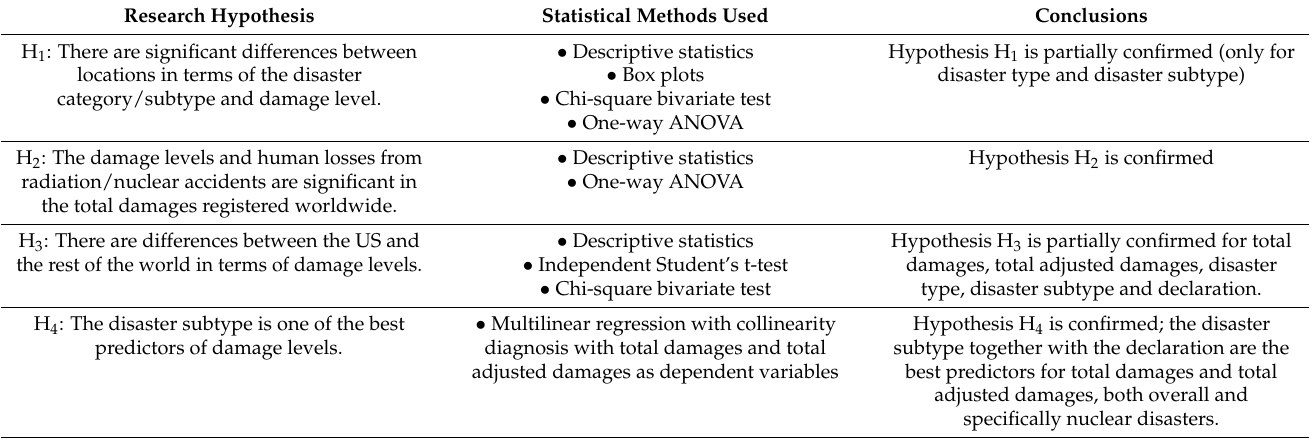
Table 11. Summary of research hypotheses, statistical methods and